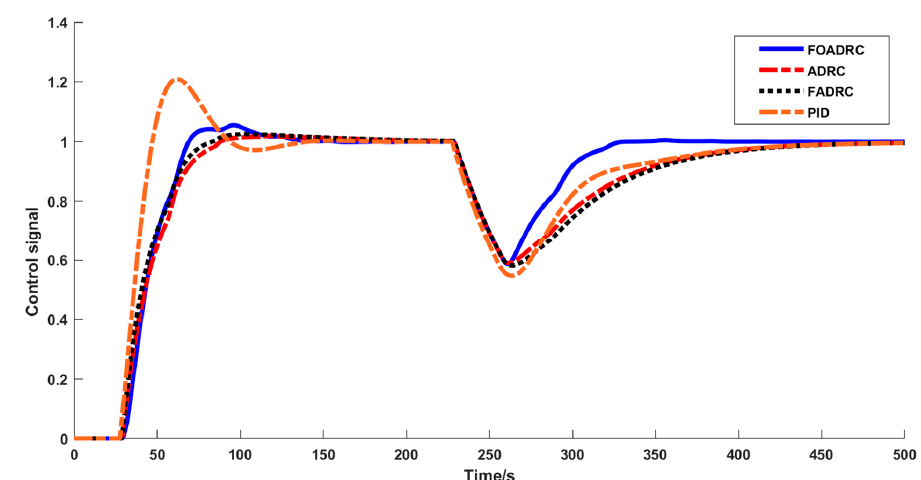
Figure 11. Model modification +10% response curve.